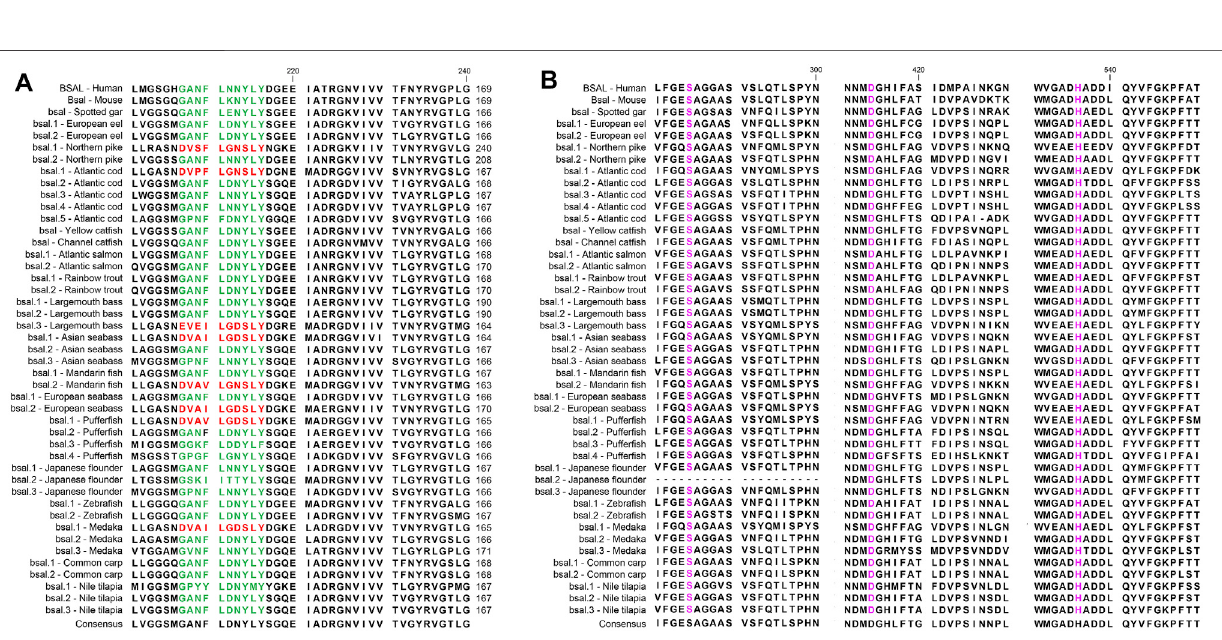
FIGURE6| PartialAminoacidsequencealignmentsofbilesalt-activatedlipasesforhumansand fi shes. (A) Thecorrectaminoacidresiduesofthebilesalt-binding site (GANFLXNYLY) were marked with green, and other types of amino acid residues in the bile salt-binding site were marked with red. (B) Active site triad residues Ser, Asp, and His were marked with pink. The dashes (-) represent gaps found upon sequence alignment. Numbers refer to the amino acid were located at the end of each line.